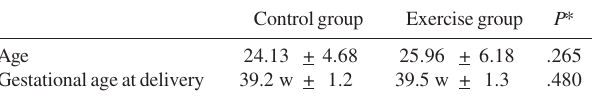
Table 1 - Mean and standard deviation of age and gestational age of the 46 patients studied (control and exercise groups) (HCFMUSP, November 2003 to December